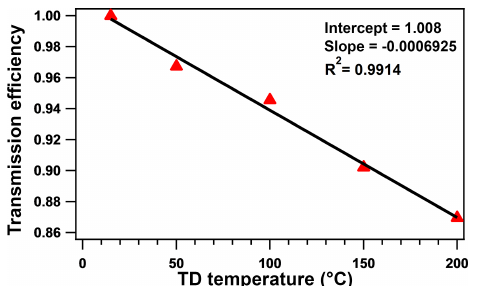
Figure 1. Temperature-related transmission efficiency through the